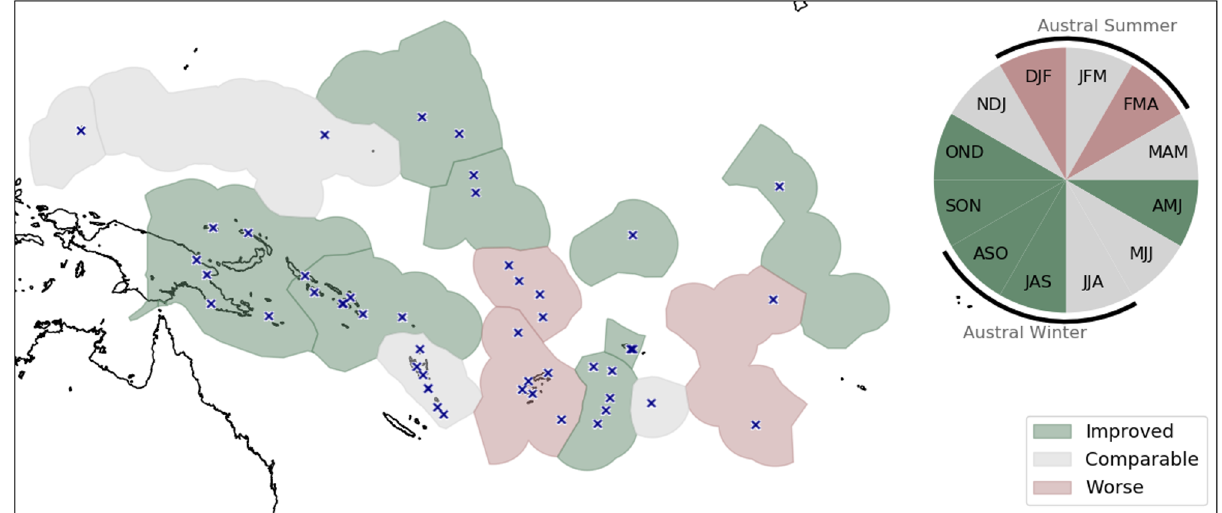
Figure 5. (Map) spatial distribution and (pie) temporal variation of relative PICASO performance inferred from 13 capital stations’ LEPS scores. Dark green, light gray, and rosy brown colors indicate the regions where the PICASO skill is improved, comparable to, or worse than the existing operational systems, respectively. The locations of 49 stations analyzed in this study are marked with